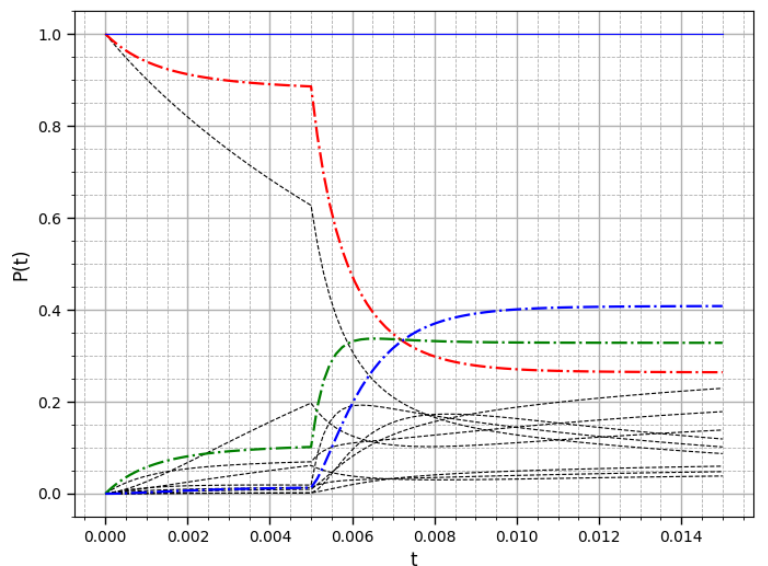
Figure 4. Dependencies of state probabilities on time in the case of an abrupt change in the arrival intensity ( λ 1 + λ < µ , λ 2 + λ > µ